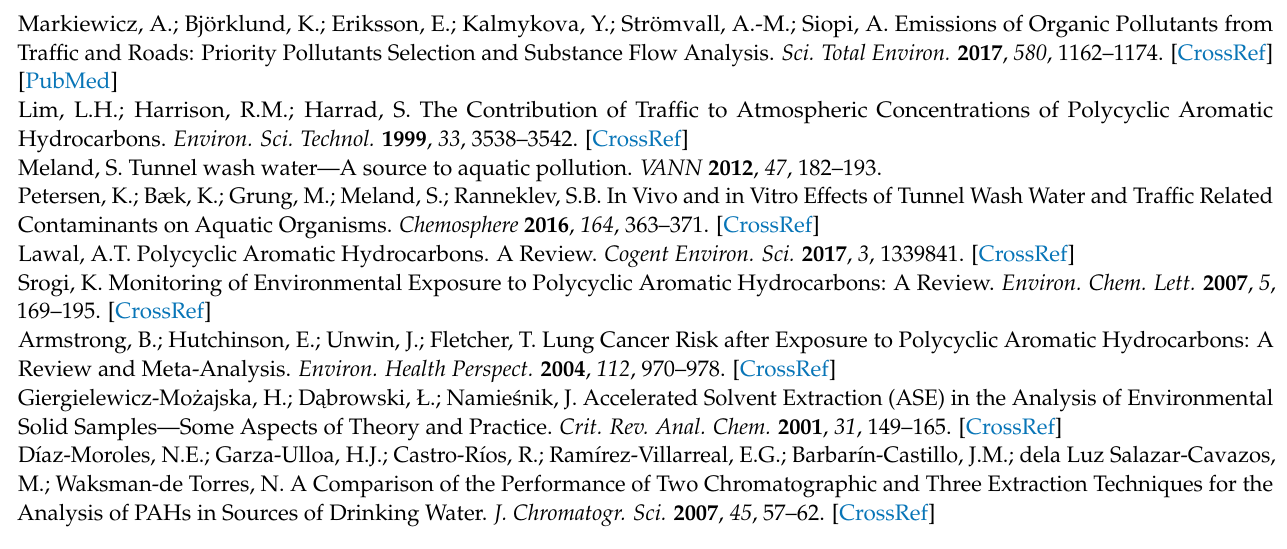
by GC-MS; Table S9: Diagnostic ratios used for PAH compounds to indicate the sources of pollution; Table S10: Summary of which internal standard compound was used to determine each of the target analyte PAHs; Table S11: Summary of average recoveries, relative standard deviations (RSD) and p-value from two-sample t-test for dissolved phase recoveries; Table S12: Summary of average recov- eries, relative standard deviations (RSD) and p-value from two-sample t-test for particulate phase recoveries; Table S13: Limits of detection (LOD) and limits of quantification (LOQ) of the 16 PAH compounds. Analyzed with HPLC-FLD and GC-MS; Table S14: Detection rates (DR), median, mean, minimum (Min) and maximum (Max) of the total concentrations ( µ g/L) for the 16 polycyclic aromatic hydrocarbons (PAH) compounds in the tunnel wash water samples ( n = 5 analyzed by the two different methods (Gas Chromatography Mass Spectrometry (GC-MS) and High-Performance Liquid Chromatography (HPLC-FLD)); Table S15: Detected concentrations ( µ g/g) of 16 PAH compounds in the particulate phase of tunnel wash water samples from 5 different tunnels in Norway; Table S16: Detected concentrations ( µ g/L) of 16 PAH compounds in the dissolved phase of tunnel wash water samples from 5 different tunnels; Table S17: Summary of PAH concentrations detected in tunnel wash water samples in other studies; Figure S1: HPLC-DAD chromatogram presenting the elution order of the target analyte ACY (peak eluting as number three from the left). The sample was a calibration standard sample with a concentration of 100 µ g/L of each PAH target